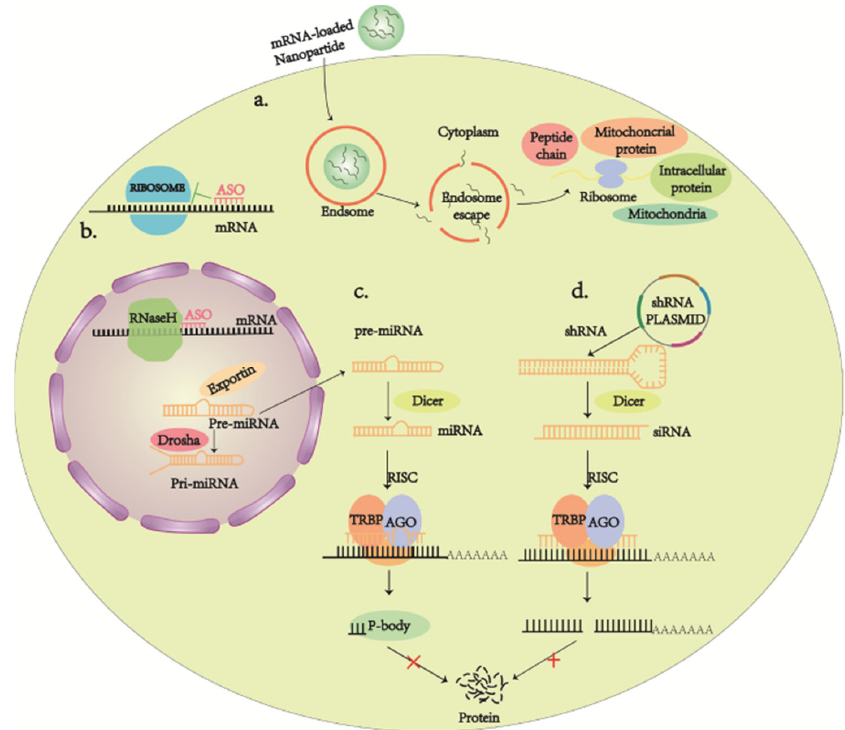
Figure 6. ( a ) In vitro mRNAs delivered into the cytoplasm via special materials are directly trans ‐ lated by ribosomes into various proteins that exert their corresponding effects. ( b ) Antisense oligo ‐ nucleotides (ASO) as chemically modified short RNA or DNA molecules that bind target mRNAs and can lead to RNase H ‐ induced cleavage (bottom) or inhibit translation (top). ( c , d ) RNAi therapies involving small interfering RNAs (SiRNAs) or similar molecules (microRNAs) that are 21–23 nucle ‐ otides long to degrade mRNA and prevent its translation into proteins.